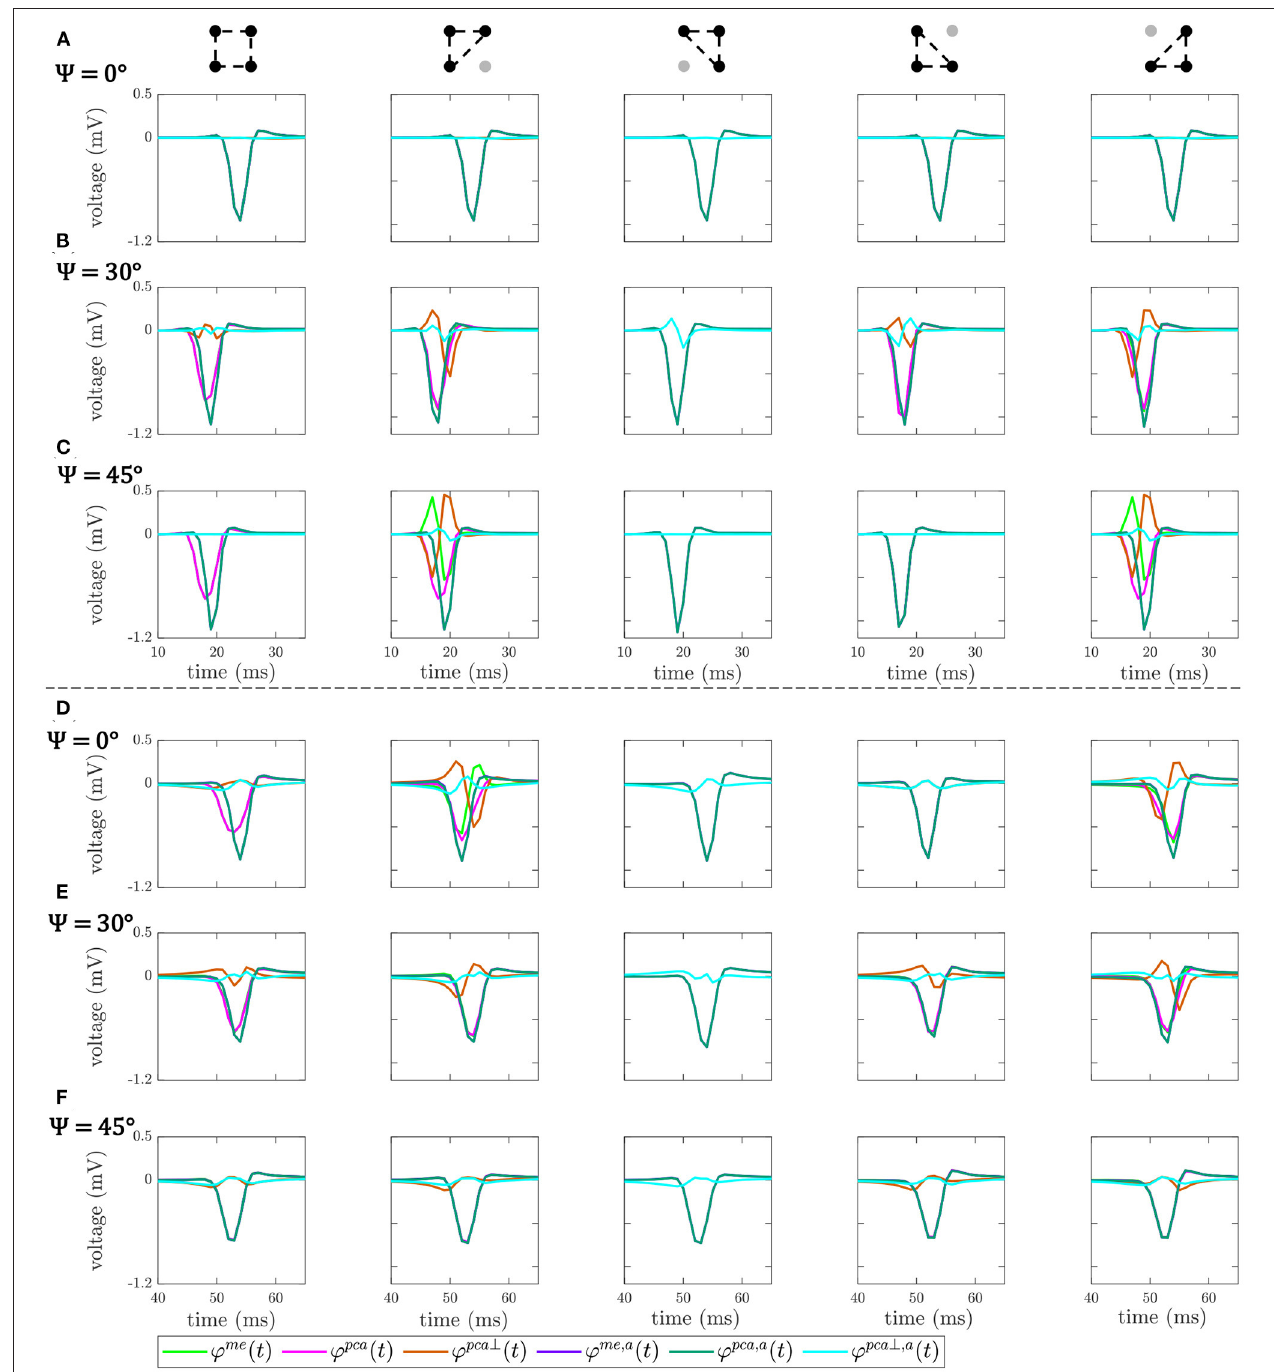
me , pca , pca , obtained in square and triangular cliques, estimated with ( a ) and without alignment of b-EGMs. All FIGURE 6 | OP-EGM signals ϕ s i , j ,( q ) ( t ), where s ∈ { ⊥} the cliques represented are from non-fibrotic areas outside the fibrotic patch. Rows (A–C) : cliques with plane wavefront, when 9 = 0 ◦ , 9 = 30 ◦ and 9 = 45 ◦ , respectively. Rows (D–F) : cliques with curved wavefront, when 9 = 0 ◦ , 9 = 30 ◦ and 9 = 45 ◦ , respectively.